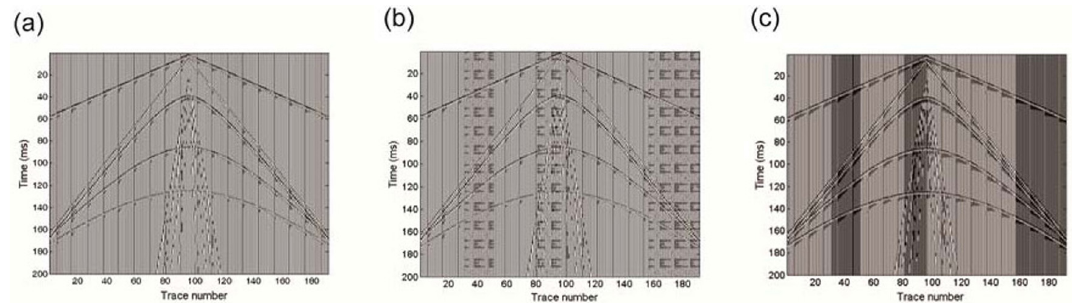
Fig. 2. Simulation of the reflection model. (a) Shot gather model without harmonic noise. (b) Model with harmonic noise and ground roll added. (c) Logarithmic transform performed on the model shown in (b) .